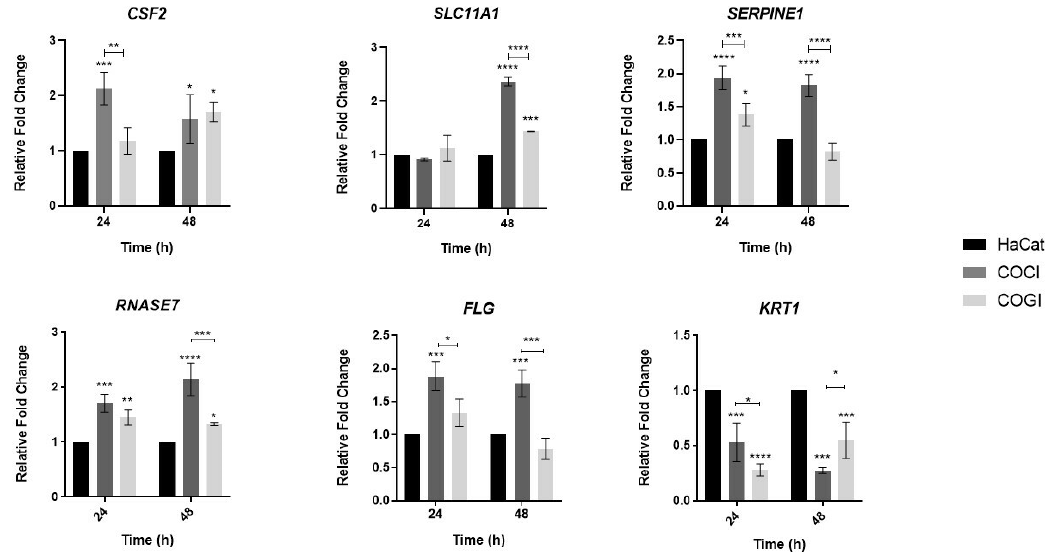
Figure 3. Expression levels of genes involved in the innate immunity ( CSF2 , RNASE7 , SLC11A1 , and SERPINE1 ) and epithelial barrier integrity ( KRT1 and FLG ) of human keratinocytes in response to heat-inactivated fungal elements of T. rubrum . HaCat: cultured keratinocytes used as control; COCI: co-culture with heat-inactivated conidial phase of T. rubrum ; COGI: co-culture with heat-inactivated germinative phase of T. rubrum . Asterisks indicate significant differences (* p < 0.05; ** p < 0.01; *** p < 0.001; **** p < 0.0001).